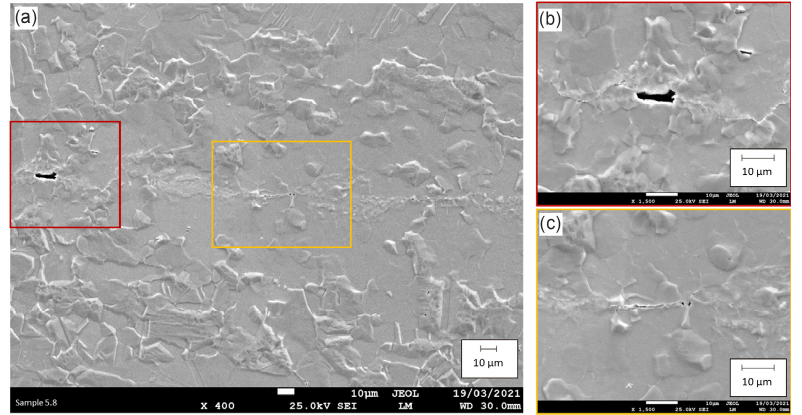
Figure 9. SEM image of porosities at ( a ) × 400; ( b ) and ( c ) × 1500.